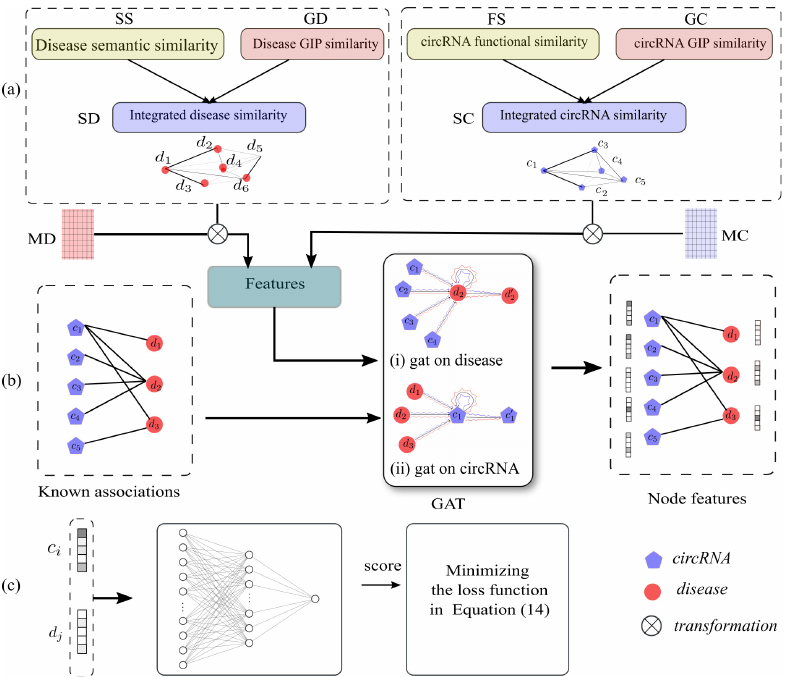
Figure 1. The framework of GATNNCDA. It consists of three steps: ( a ) similarity integration for circRNA and disease, ( b ) GAT-based feature extraction, and ( c ) NN-based